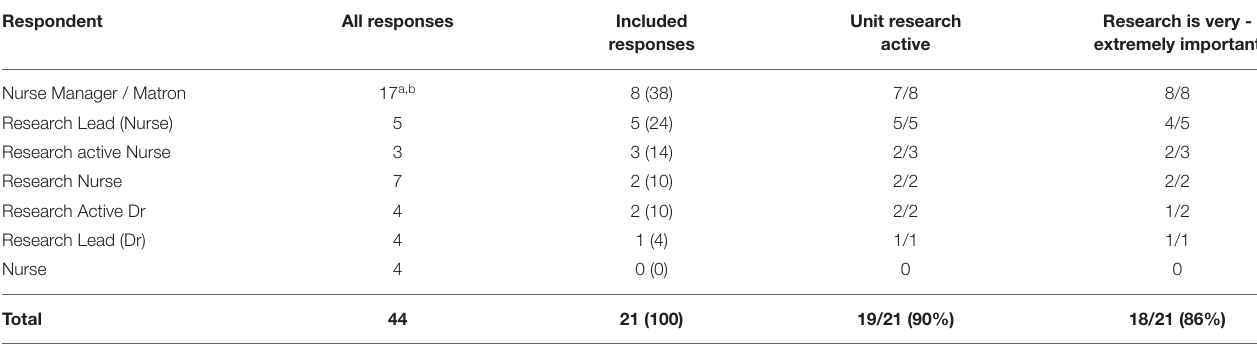
TABLE 1 | UK/ IRL units survey